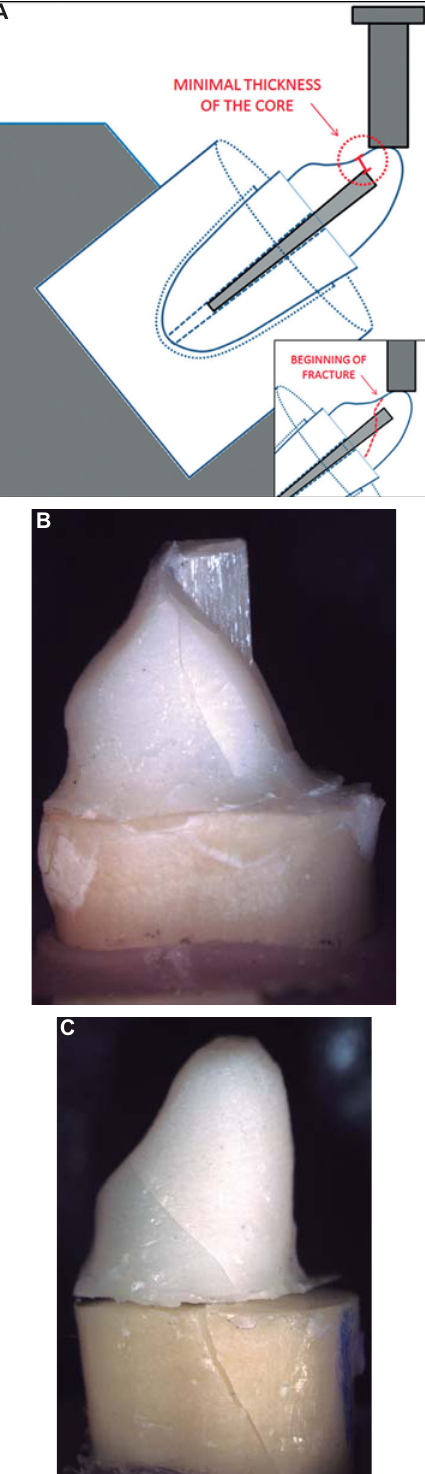
Figure 4- (A) Schematic diagram of the specimen positioned for the test, indicating the minimal thickness area (lingual portion) of the core where the fracture initiates. (B) Stereomicroscope representative image of specimen fractured in the mesiodistal direction (group C). (C) Root fracture associated with core fracture (group addition silicone) after the fracture resistance